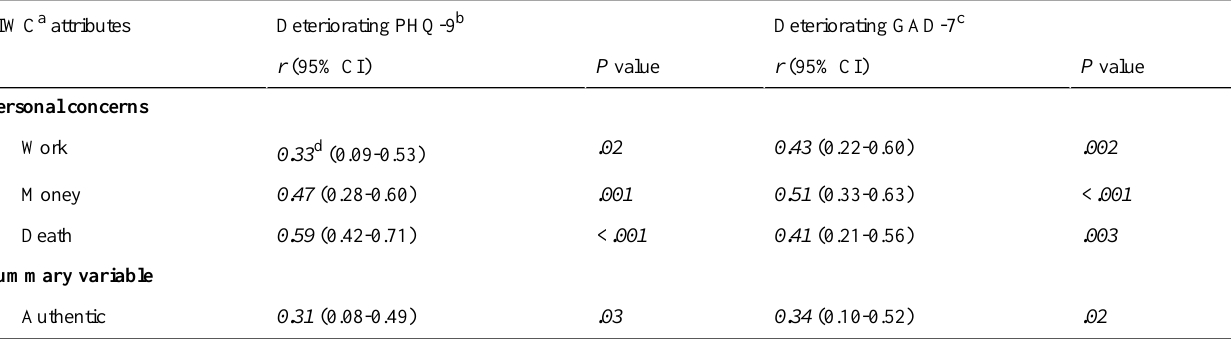
Table 4. The significant LIWC features from Google Search histories and their correlation coefficients with deteriorating PHQ-9 and GAD-7 scores.